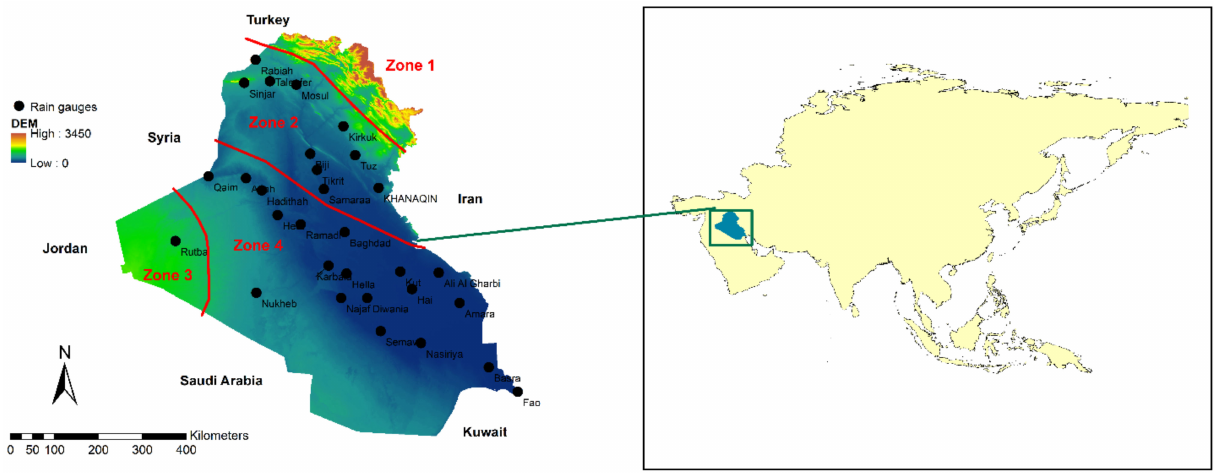
Figure 1. Elevation map of Iraq with climatic